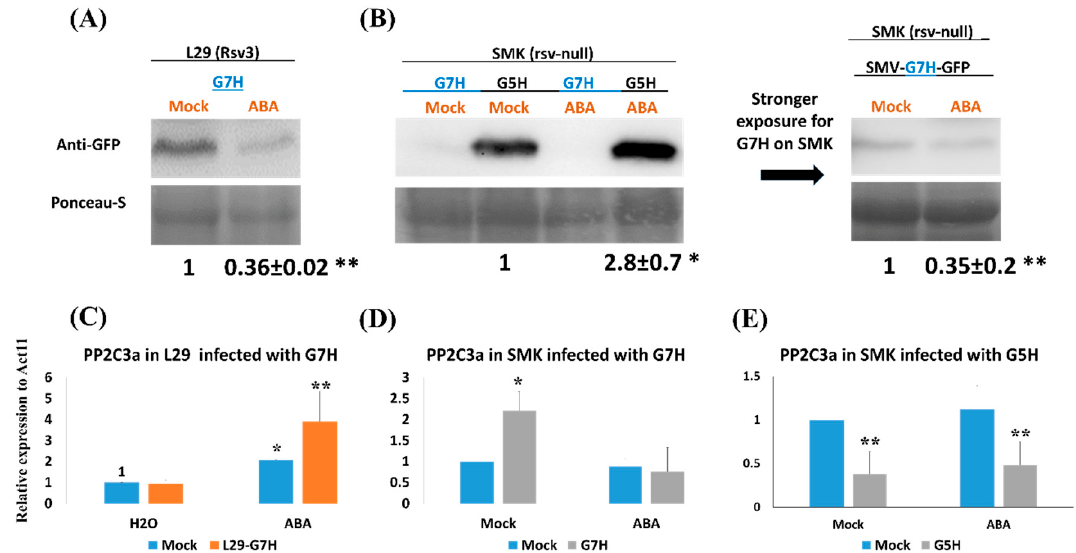
Figure 1. Effect of abscisic acid (ABA) treatment on the accumulation of soybean mosaic virus (SMV) strains and on PP2C3a expression in L29 and Somyungkong (SMK) soybean cultivars. Protein blots of the soybean mosaic virus (SMV) in response to exogenous application of ABA (100 µ M) or Mock (0.1 % MeOH) in: ( A ) L29 cultivar (carries the Rsv3 resistance gene) infected with the virulent strain G7H, or ( B ) SMK cultivar (rsv3-null) infected with G7H or the avirulent strain G5H (both strains express GFP). The upper panel shows the GFP level, and the lower panel shows Ponceau-S, which was used as a loading control. Relative expression levels of PP2C3a using RT-qPCR in response to G7H infection in L29 plants ( C ), G7H infection in SMK plants ( D ), and G5H plants ( E ). Actin11 was used as the internal control. Plants were sampled at 5 dpi. For ( C – E ), values are means standard deviation (SD) of three biological replicates. In each panel, values were compared to that of the mock-treated, uninfected plants (the bar on the left) with one-sided Student’s t -tests; * and ** indicate a significant difference at P < 0.05 and <0.01, respectively.